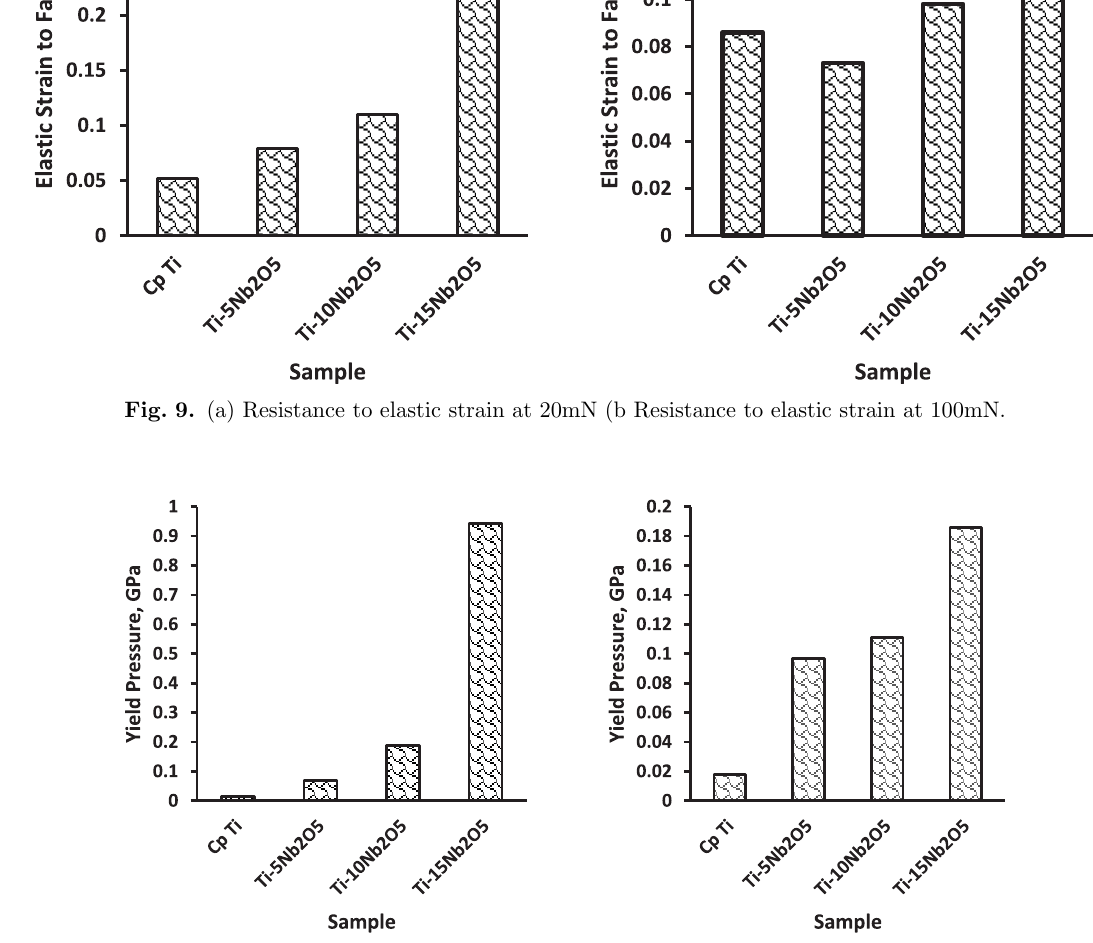
Fig. 10. (a) Yield pressure at 20mN (b) Yield pressure at